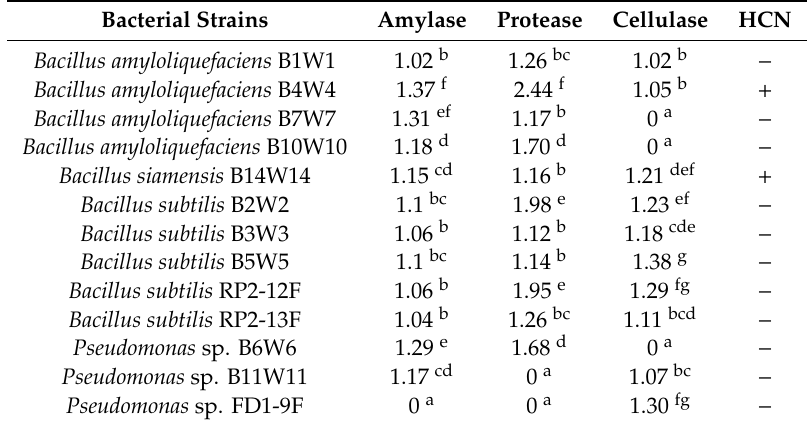
Table 3. Capacity of bacterial antagonists to produce lytic enzymes involved in the biocontrol mechanisms such as amylase, protease, cellulase and hydrocyanic acid (HCN)